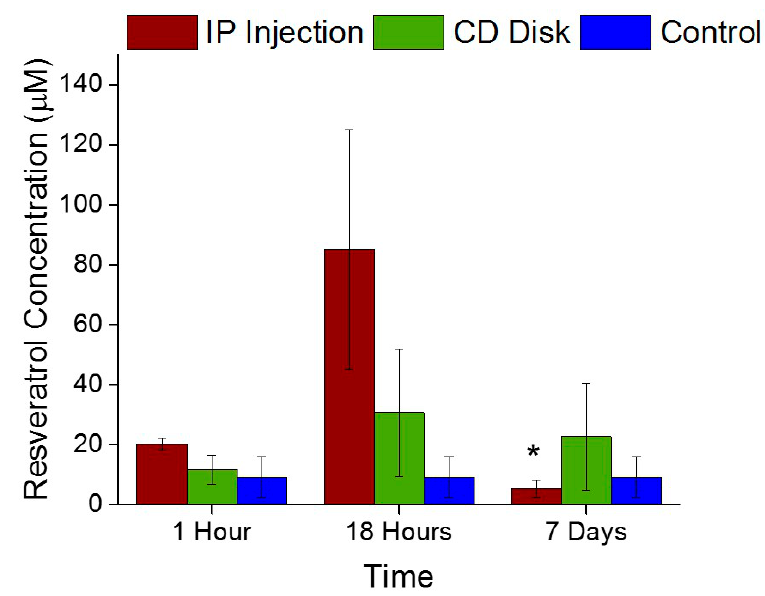
Figure 4. Mass Spectrometry of resveratrol. There was a significant decrease (* represents p = 0.05) of resveratrol concentration from 18 h to 7 days from IP administration. There was a sustained release of resveratrol from the pCD loaded disks up to 7 days in vivo.